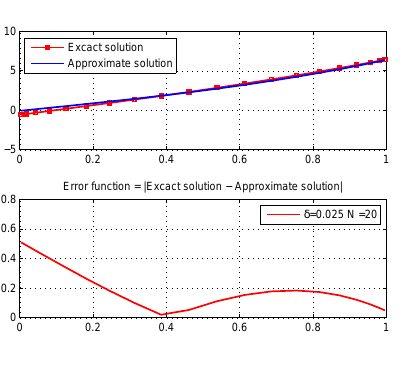
Figure 3. Example 3: exact and computed approximate solutions, absolute errors with n = 20 and noise level 2 . 5%.